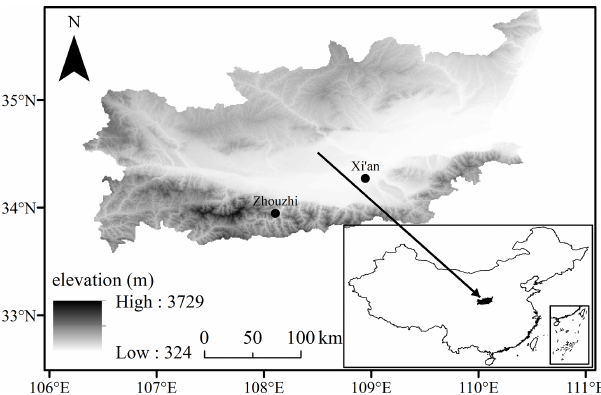
Figure 2. The location of the Guanzhong region for the climatic reconstructions in this study with the modern names of sites men- tioned in the poems. Publisher’s note: please note that the above figure contains disputed